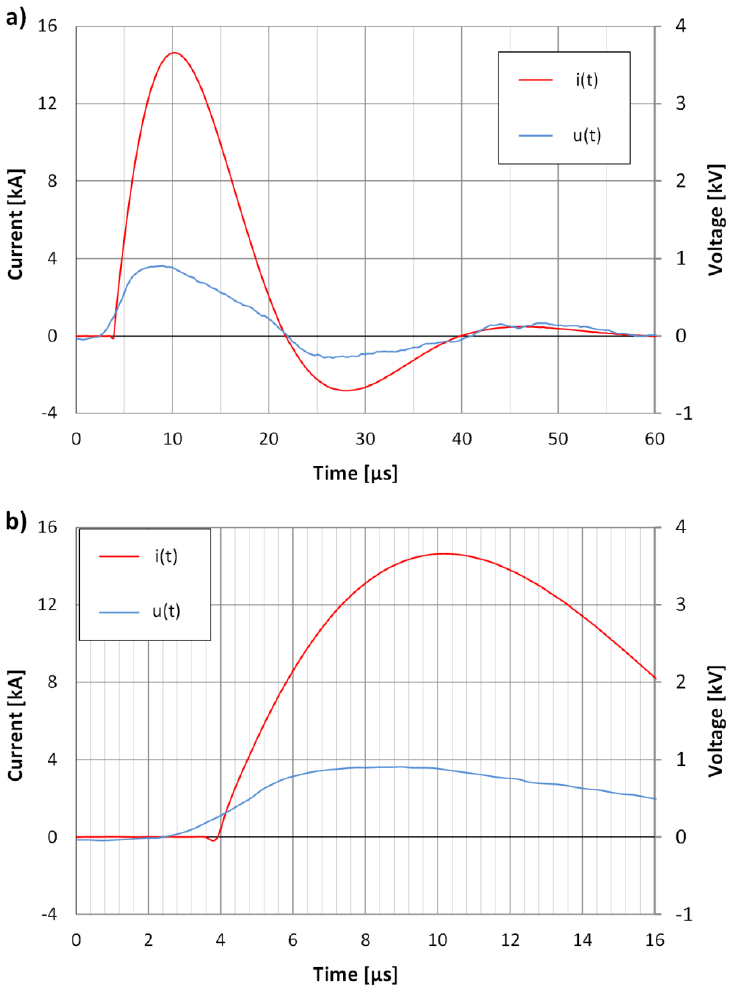
Figure 8. Voltage and current time signals in the CFRP3 sample during the last test impulse: ( a ) full time scale, ( b ) enlarged time scale.